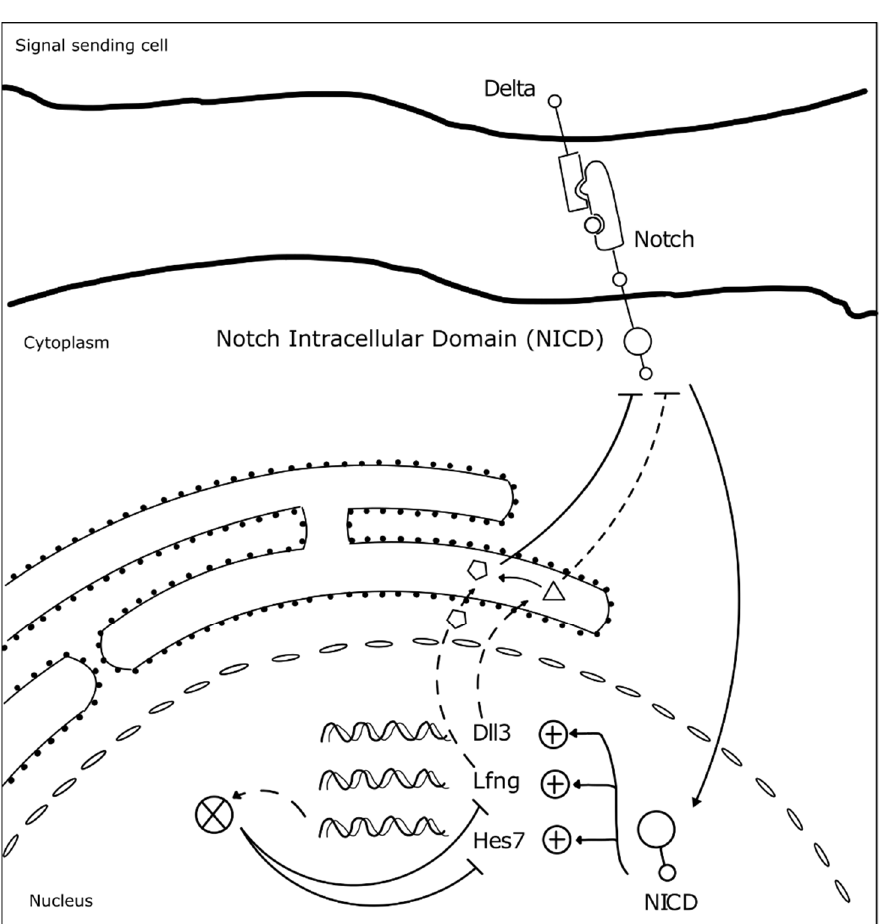
Figure 3. Negative feedback loops underlie somitogenesis clock oscillations. The identified mutated genes in SCDO are represented. Upon Notch receptor activation by a Delta ligand from a neighbor cell, the Notch intracellular domain (NICD) translocates to the nucleus where it activates the transcription of HES7, LFNG and DLL3 [23]. Lfng and Dll3 act cooperatively to repress further NICD activation [50], while Hes7 acts to represses its own expression and that of Lfng [23].